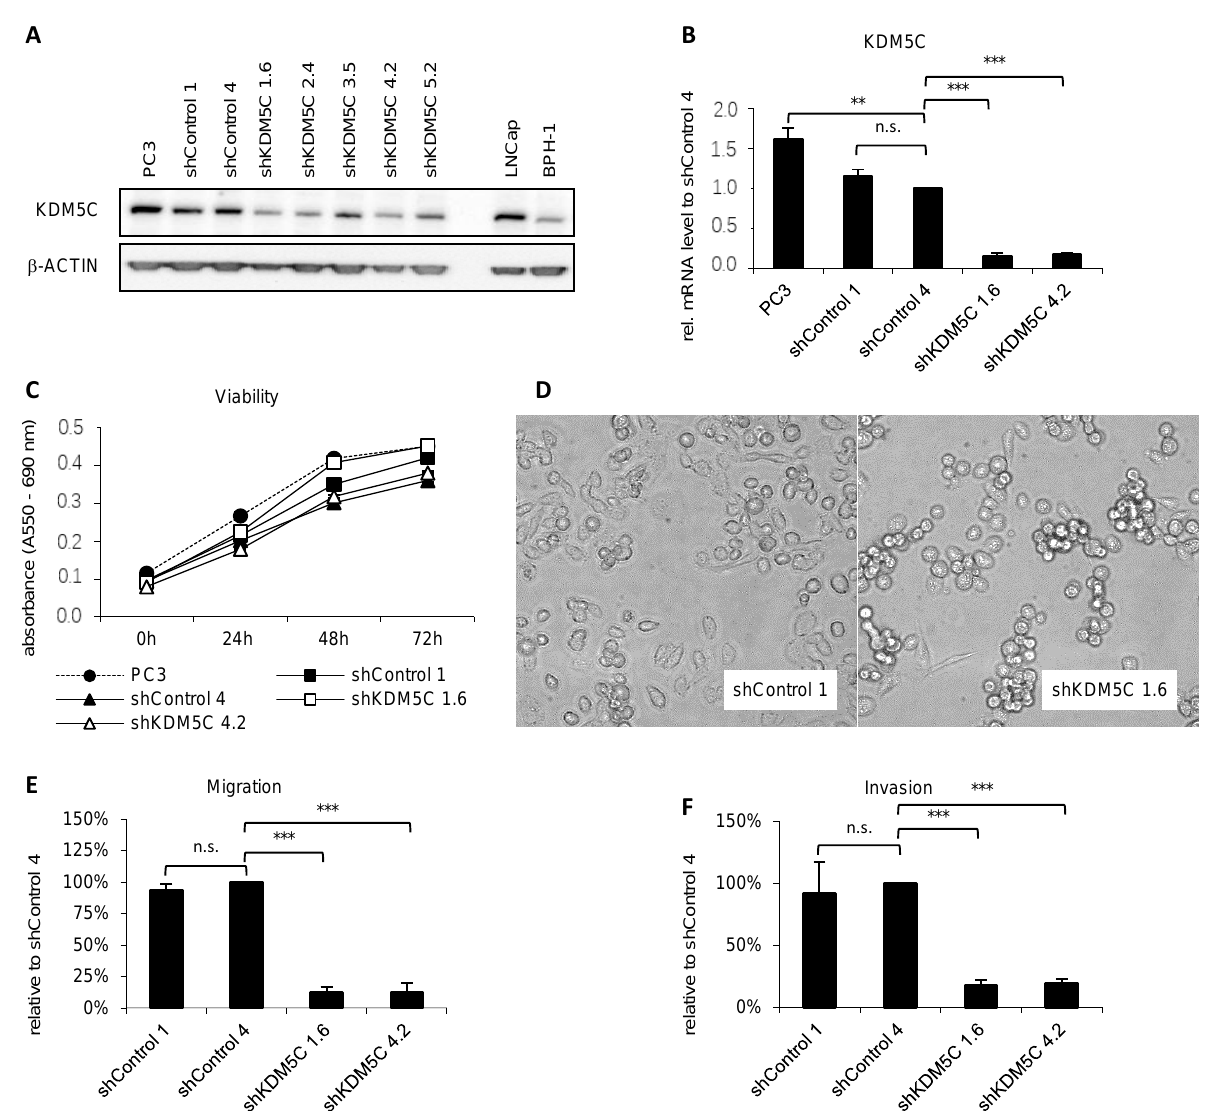
Figure 2. KDM5C expression after shRNA-mediated knockdown. ( A ) Representative Western blot of KDM5C expression in prostate cancer cell line PC3, different shRNA-transduced cell clones, LNCap, and BPH-1. ShControl clones with GFP serve as a control for the lentiviral transduction procedure. The loading control is β -ACTIN; ( B ) qRT-PCR analysis of KDM5C mRNA expression in prostate cancer cell line PC3 and different shRNA-transduced GFP control as well as KDM5C knockdown clones. mRNA expression was normalized to the nuclear housekeeper TBP and in relation to the shControl 4 clone. Error bars represent standard error of the mean from three independent experiments; ( C ) Viability of PC3 cells and several shRNA-transduced cell clones. One representative MTT assay of the parental cell line PC3 and its derived shRNA-controlled clones. Error bars represent standard error of the mean from the quintuplicates; ( D ) Phenotype of shControl clones compared to KDM5C knockdown clones. KDM5C knockdown cells were less adherent to the flask compared with control cells (15 × magnification); ( E ) Migration and ( F ) Invasion of PC3 derived shRNA-transduced cell clones tested by Boyden and Invasion chamber assays. Error bars represent standard error of the mean from three independent experiments. (n.s. = not significant; ** = p < 0.01; *** = p < 0.001).